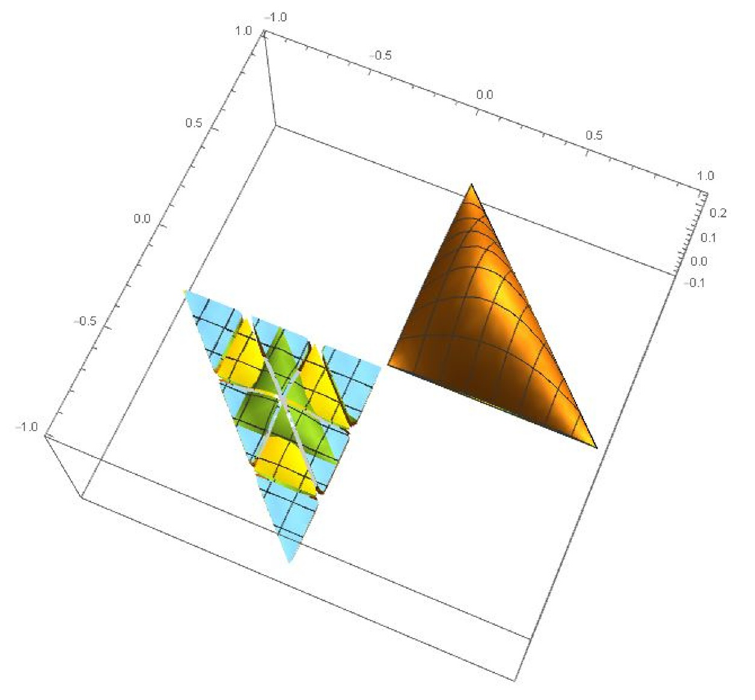
Figure 2. The functions C (cid:0) 3 P 3 and C = 6